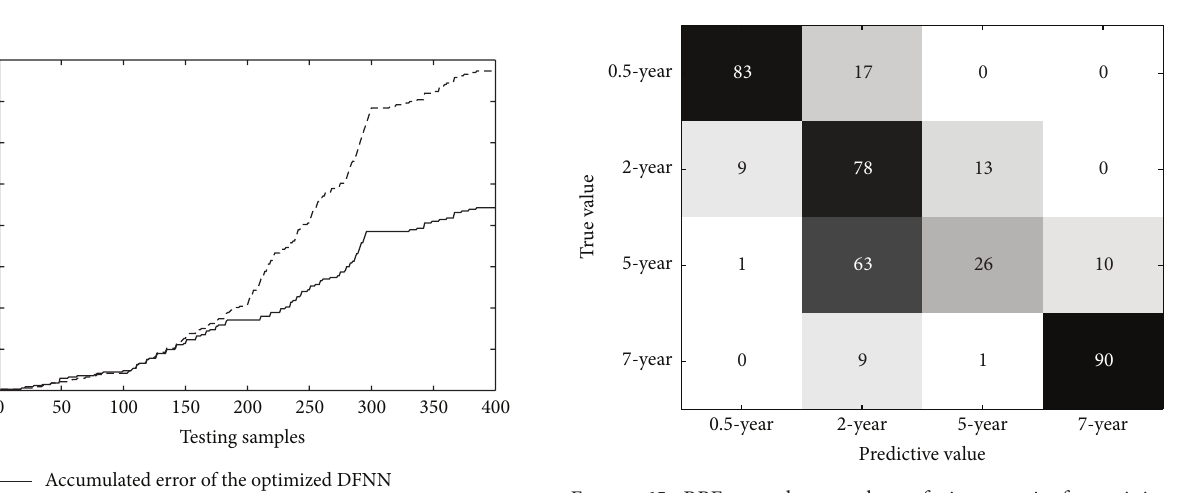
Figure 11: Training accumulated errors of two DFNN.